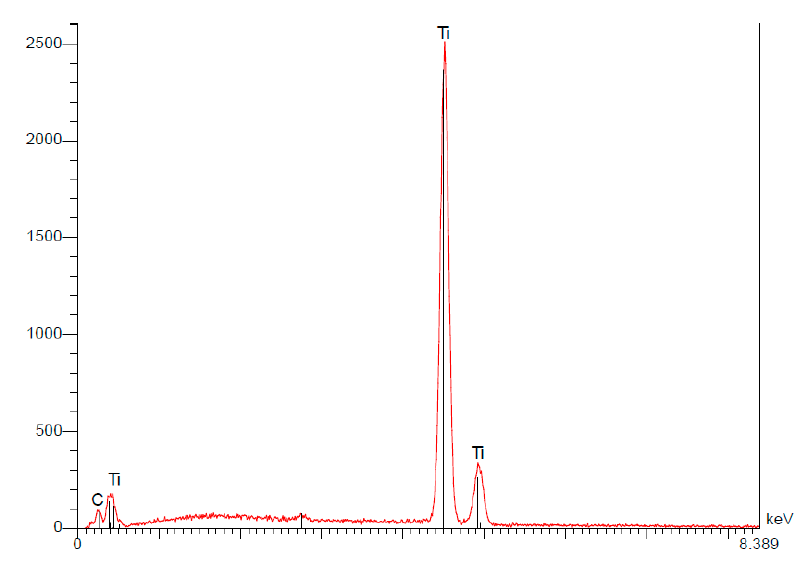
Figure 7. The spectroscopy of the Straumann implant’s neck. Table 5. The quantitative results of the EDS analysis of the Straumann implant’s neck demonstrating weight percentages (P%) and atomic percentages (A%) of the elements detected